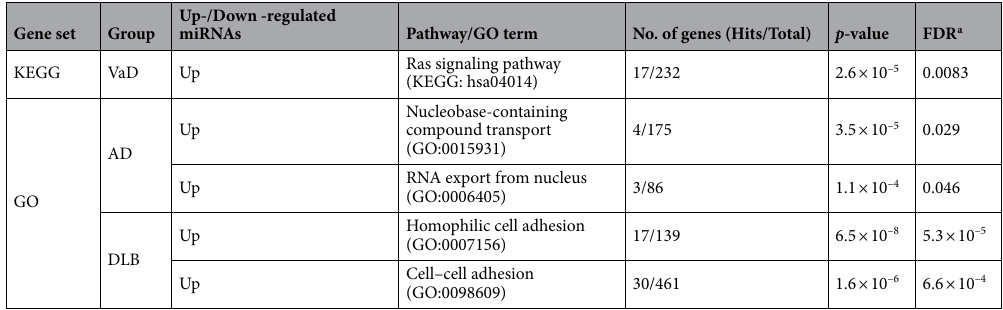
Table 2. Gene set enrichment analyses using the target genes of the miRNAs. a FDR false discovery rate.